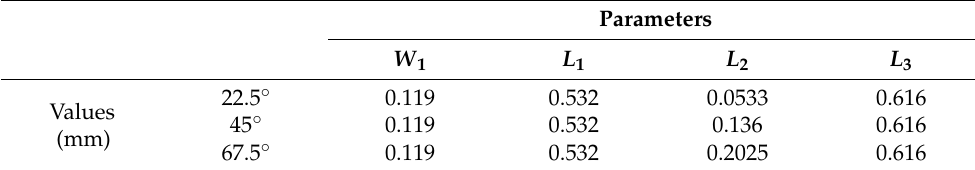
Table 7. Optimized dimensions of the phase